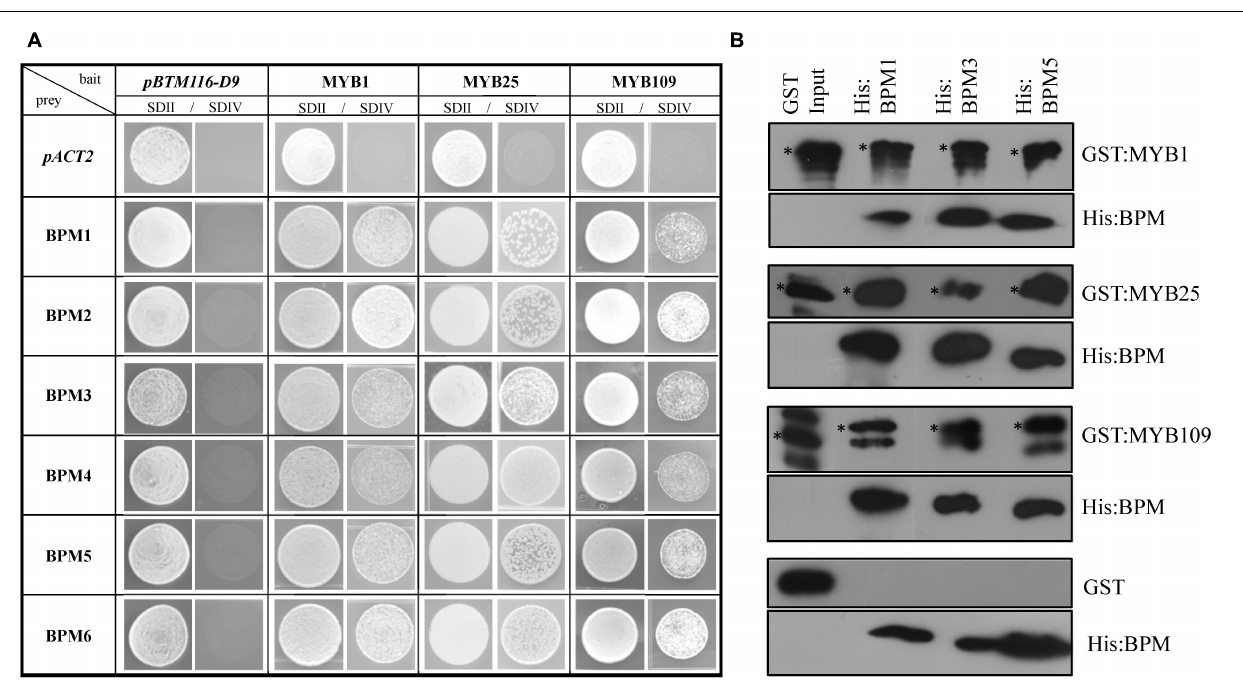
FIGURE 2 | Yeast 2-hybrid and in vitro pulldown assays show interaction of S23 family members with the Arabidopsis BPM family. (A) Yeast 2-hybrid analysis shows that MYB1, MYB25, and MYB109 can interact with all members of the Arabidopsis BPM family. SDII is the selection medium for transformation with the bait vector pBTM112-D9 , and the prey plasmid pACT2 supplemented with uracil and His; SDIV is the selection medium for interaction studies without uracil and His supplements. Images were taken from single spots. (B) Pulldown analysis with purified, recombinant proteins show that all three His-tagged BPM proteins (His:BPM1, :BPM3, and :BPM5) were able to co-precipitate GST-tagged MYB1, MYB25, and MYB109, while GST alone did not interact with any of the His:BPM proteins. If not otherwise stated, all results in this and subsequent figures were repeated at least three times independently. ∗ , indicate full-length recombinant GST-fusion proteins (GST:MYB1 ∼ 69.7 kDa; GST:MYB25 ∼ 67.8; GST:MYB109 ∼ 70.4 kDa). Additional bands are likely either unspecific cross-reactions with the antibody or truncated recombinant